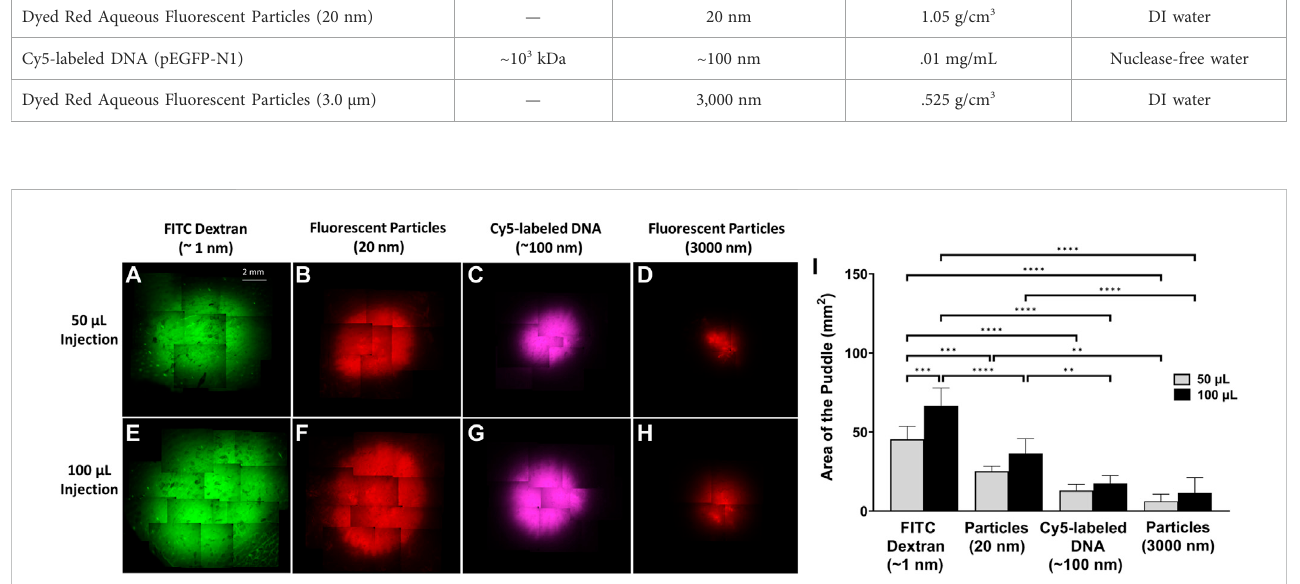
Puddle area dependence on molecular/particle size and injection volume. ×4 objective top-view fl uorescent images of the puddle post ID injections. (A – D) 50 µL solution. (E – H) 100 µL solution. (I) Areas of the puddle resulting from 50 to 100 µL injections for the different molecules/particles. n = 6 each. Data represents mean ± SD. Statistics are presented as ** p ≤ .01, *** p ≤ .001, and **** p ≤ .0001 by ordinary one-way ANOVA followed by a Tukey ’ s multiple comparisons